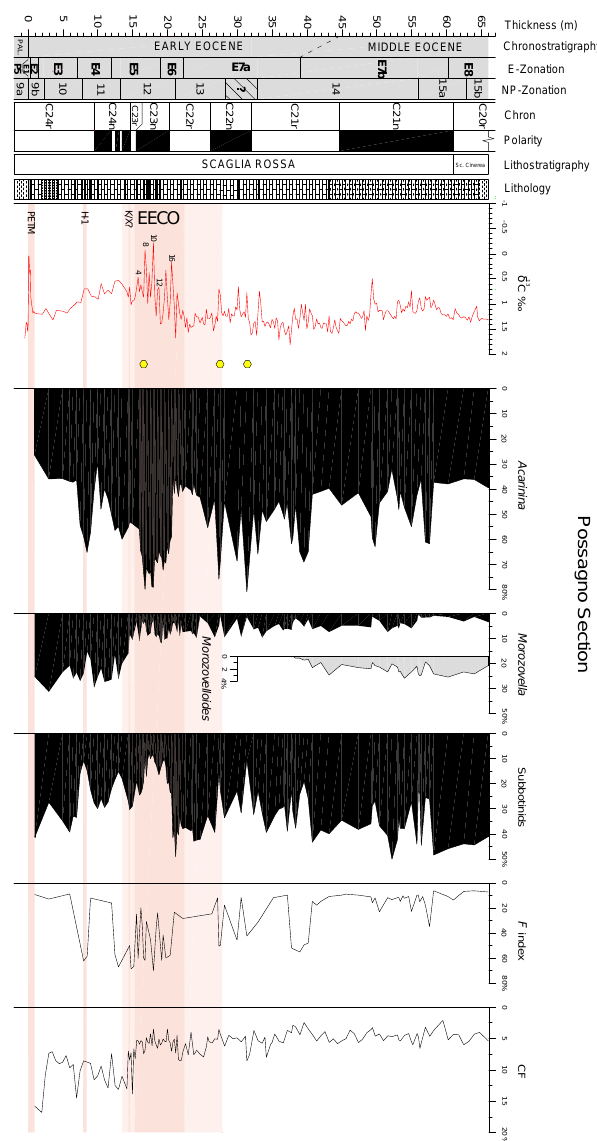
Figure 6. The Possagno section and its δ 13 C record (Fig. 4) with measured relative abundances of primary planktic foraminiferal genera, fragmentation index ( F -index) and coarse fraction (CF). The subbotinid abundance includes both Subbotina and Parasub- botina genera. Note that a significant increase in Acarinina abun- dance marks the EECO and several carbon isotope excursions (CIEs). Note also the major decline in abundance of Morozovella at the start of the EECO. Filled yellow hexagons show occurrences of abundant radiolarians. Lithological symbols and early Eocene events are the same as those in Fig.